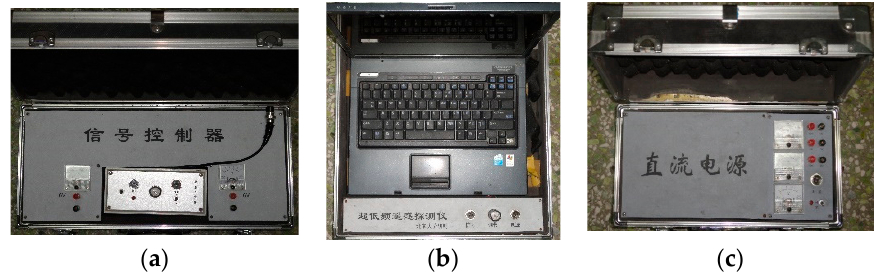
Figure 5. Magnetic component detector system ( a ) High-precision magnetic sensor; ( b ) Host control system; ( c ) Portable power supply equipment.